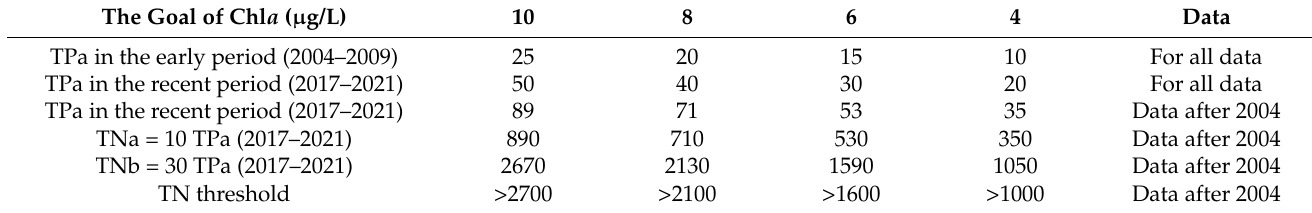
Table 2. TP- and TN-carrying concentrations ( µ g/L) under different Chl a levels (P =